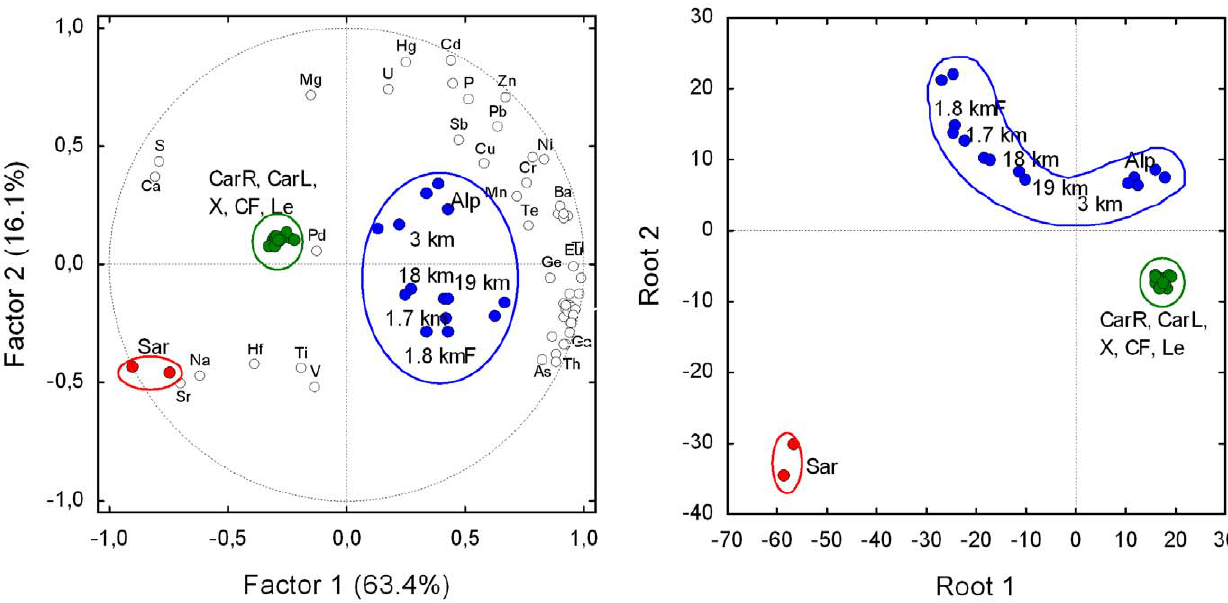
Figure 3. Left: bi-plot after Principal components and classification analysis based on correlation of the content of the 54 chemical elements (empty marker, not all labelled) in the 29 soil samples (full marker). The variance explained by the each principal component is shown in parentheses. Right: plot of canonical scores after Discriminant analysis with canonical analysis performed with the four chemical elements most, and significantly, correlated (absolute value) with factor 1 (Cs, Ga, Ca, S) and factor 2 (Cd, Zn, Hg, Sr). Classification of soil samples has an high probability to be correct (93%) as the predicted classification deviates only for sample ‘‘Le’’, that is not distinct from ‘‘X’’ (see fig. 1d). Since these two samples are in the same group (the green one), group classification is 100% correct. For technical details of multivariate techniques see Statistica 7.0 Electronic Manual (Statsoft Inc., 2005).